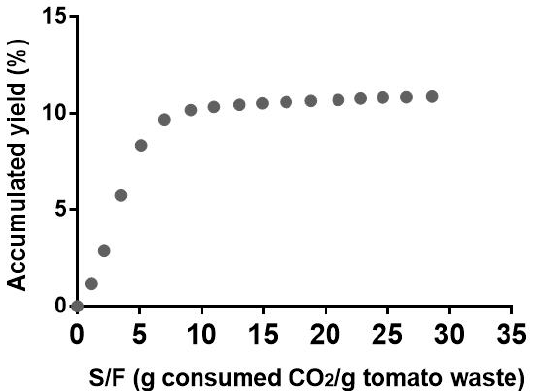
Figure 3. SFE extraction kinetics of oil from tomato waste at 500 bar and 60 ◦ C. S/F: mass ratio of solvent to feed.